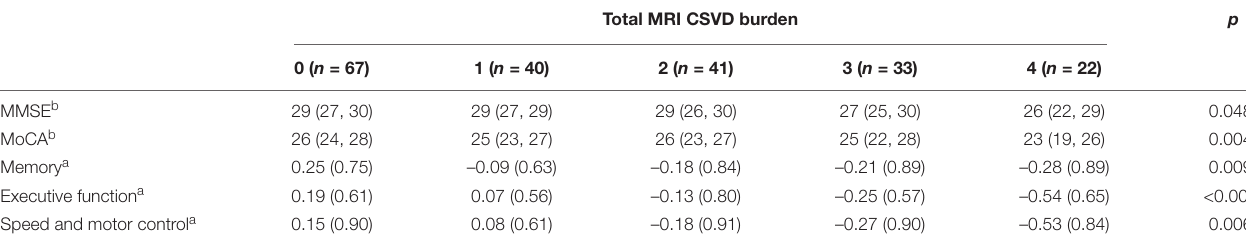
TABLE 4 | Comparison for cognitive function among different grades of total MRI CSVD burden after propensity score matching.